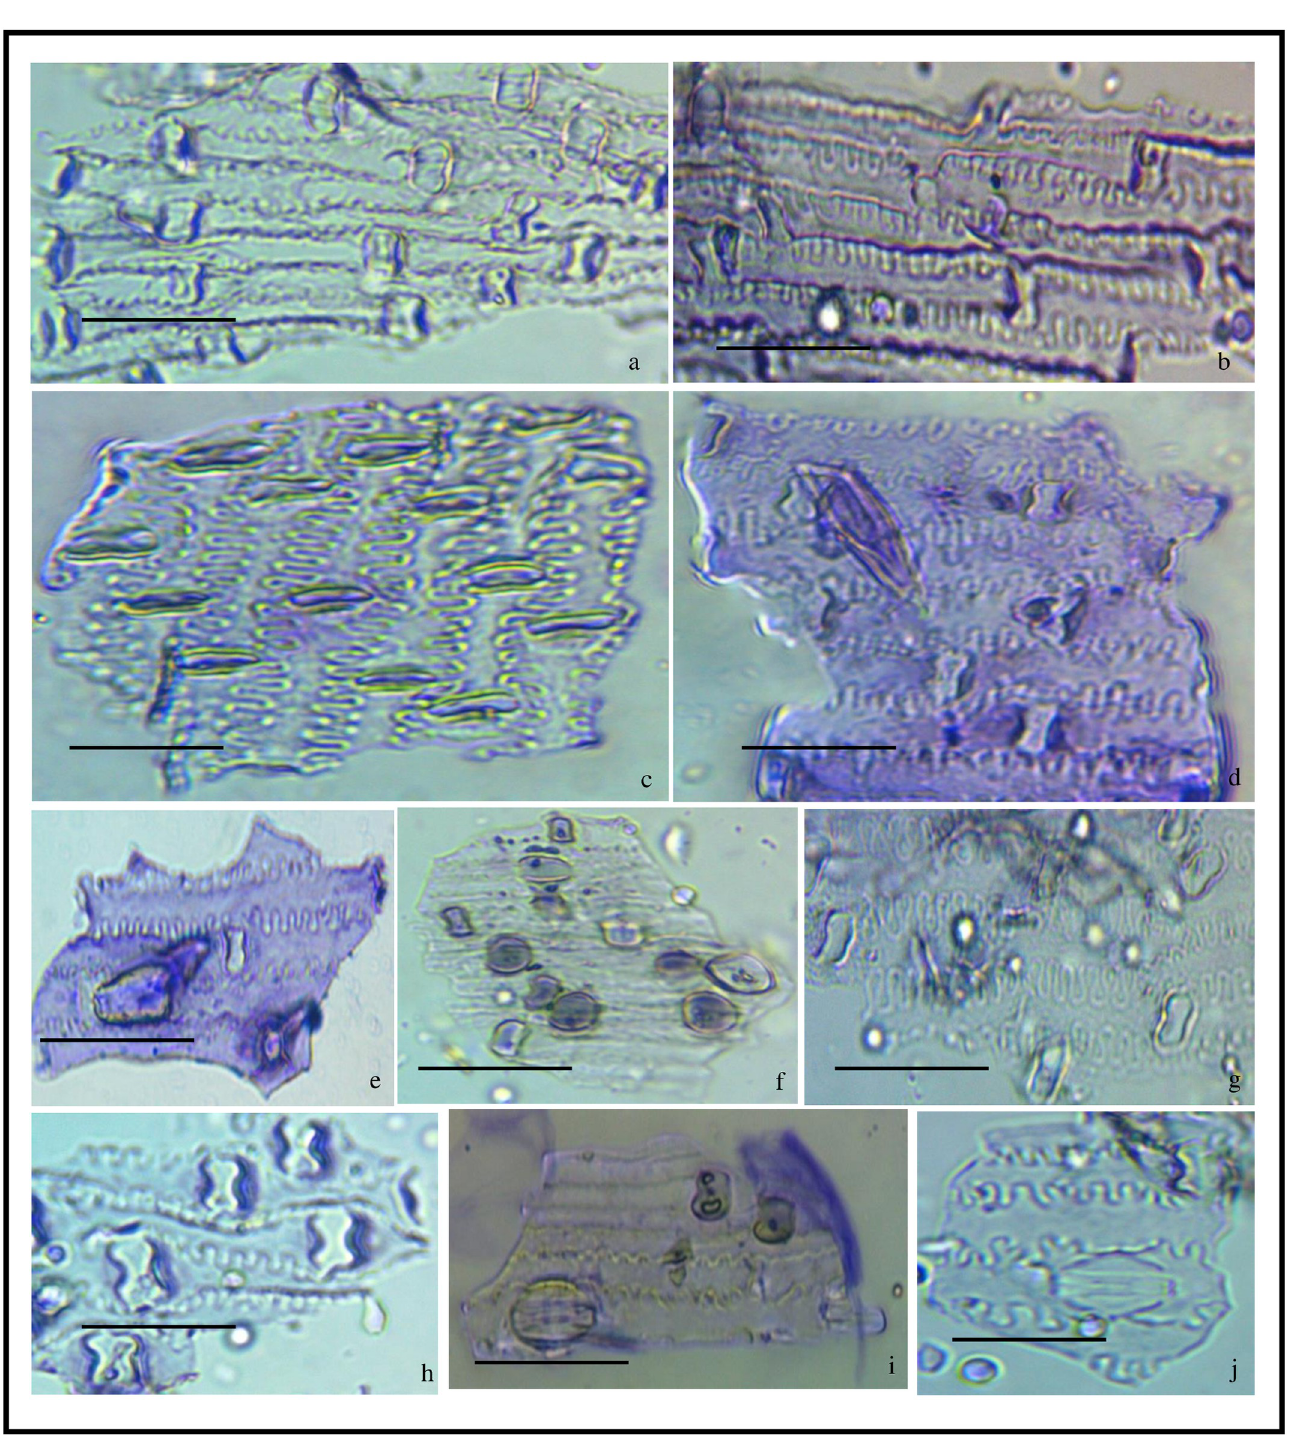
Fig 7. Undulated patterns in Acrachne racemosa (Heyne ex Roem. & Schult.) Ohwi (Synflorescence). Elongate granulate/bilobates (a); Elongate columellate/ biolobate (b); Elongate Columellate/cork cells (c); Elongate granulate/bilobates/prickle hair (d, e); Elongate granulate/saddle (f); Elongate clavate/bilobates (g); Elongate granulate/cross (h); Elongate castellate/stomata/saddle (i); Elongate castellate (j). bar = 40 μ m.